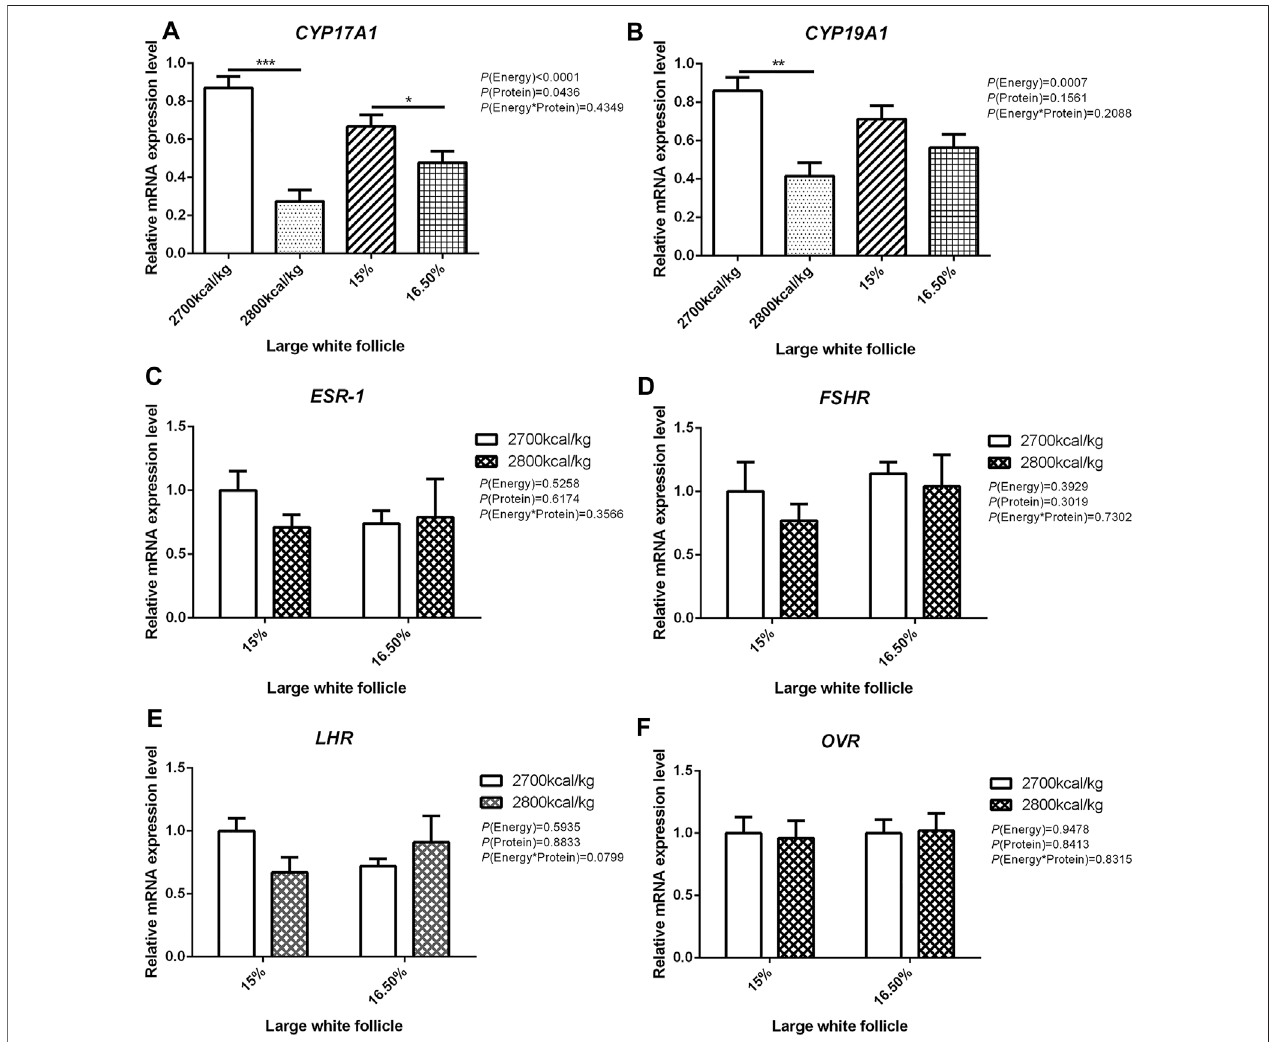
FIGURE4 | Effect of dietary metabolizable energy (E) and crude protein (P) levels during the prelay period (15 – 20 weeks of age) on themRNA expression of genes CYP17A1 (A) , CYP19A1 (B) , ESR-1 (C) , FSHR (D) , LHR (E) ,and OVR (F) inthelarge whitefollicles ofhens. Datarepresentthemean±SD ( n =4); p p < 0.05, pp p < 0.01, ppp p <